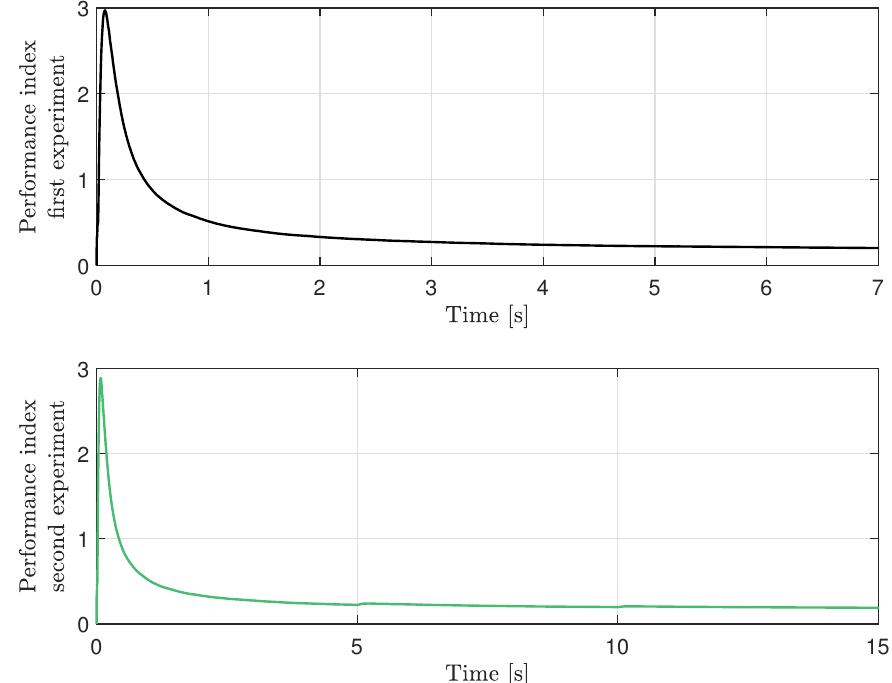
Figure 7. Performance index of first and second